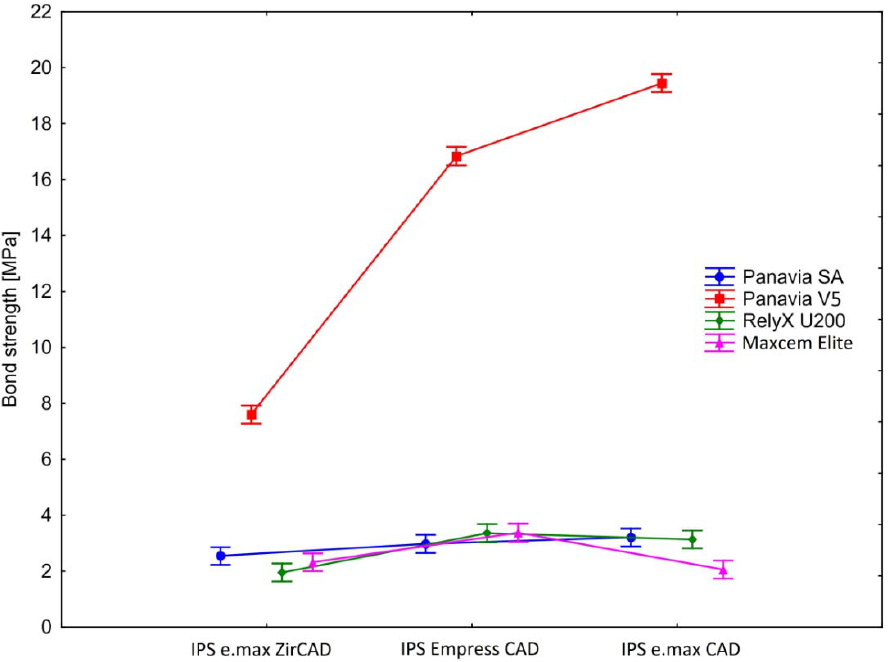
Figure 1. Shear bond strength in the examined samples. Vertical bars denote 0.95 confidence intervals.